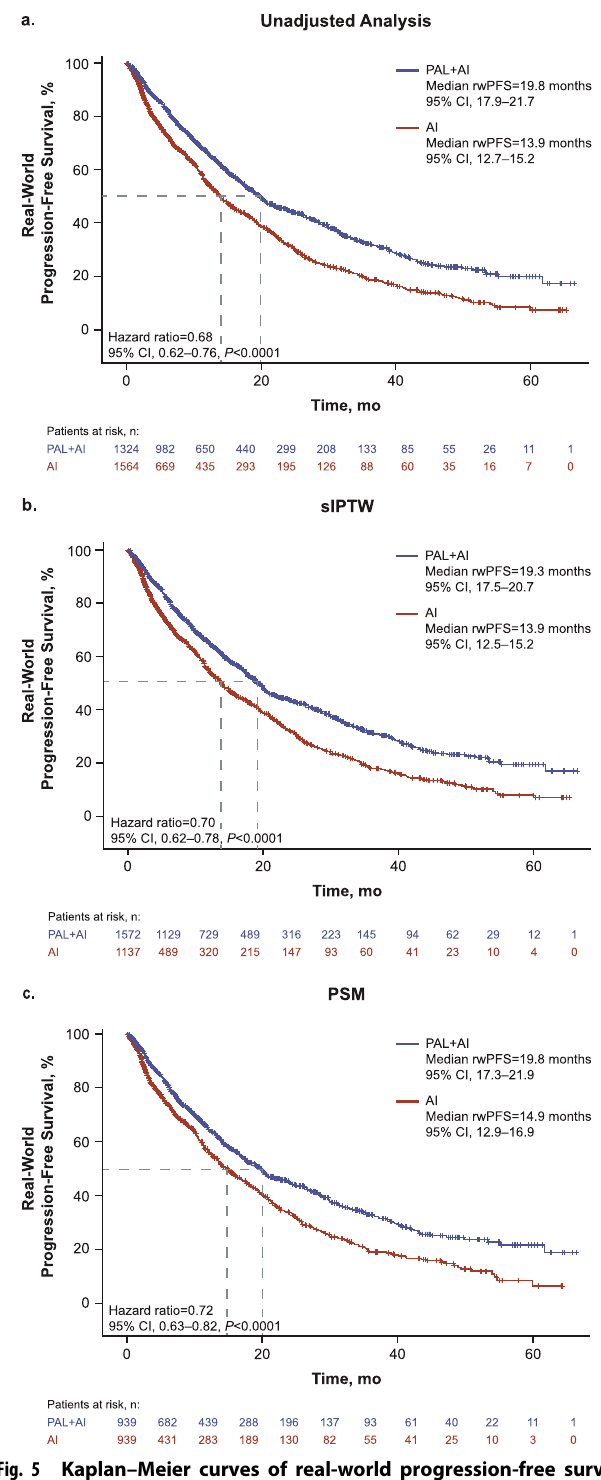
Fig. 5 Kaplan – Meier curves of real-world progression-free survi- val. AI aromatase inhibitor; PAL palbociclib; PSM propensity score matching; rwPFS real-world progression-free survival; sIPTW stabi- lized inverse probability of treatment weighting. Statistical signi fi - cance was analyzed by a weighted Cox proportional hazards